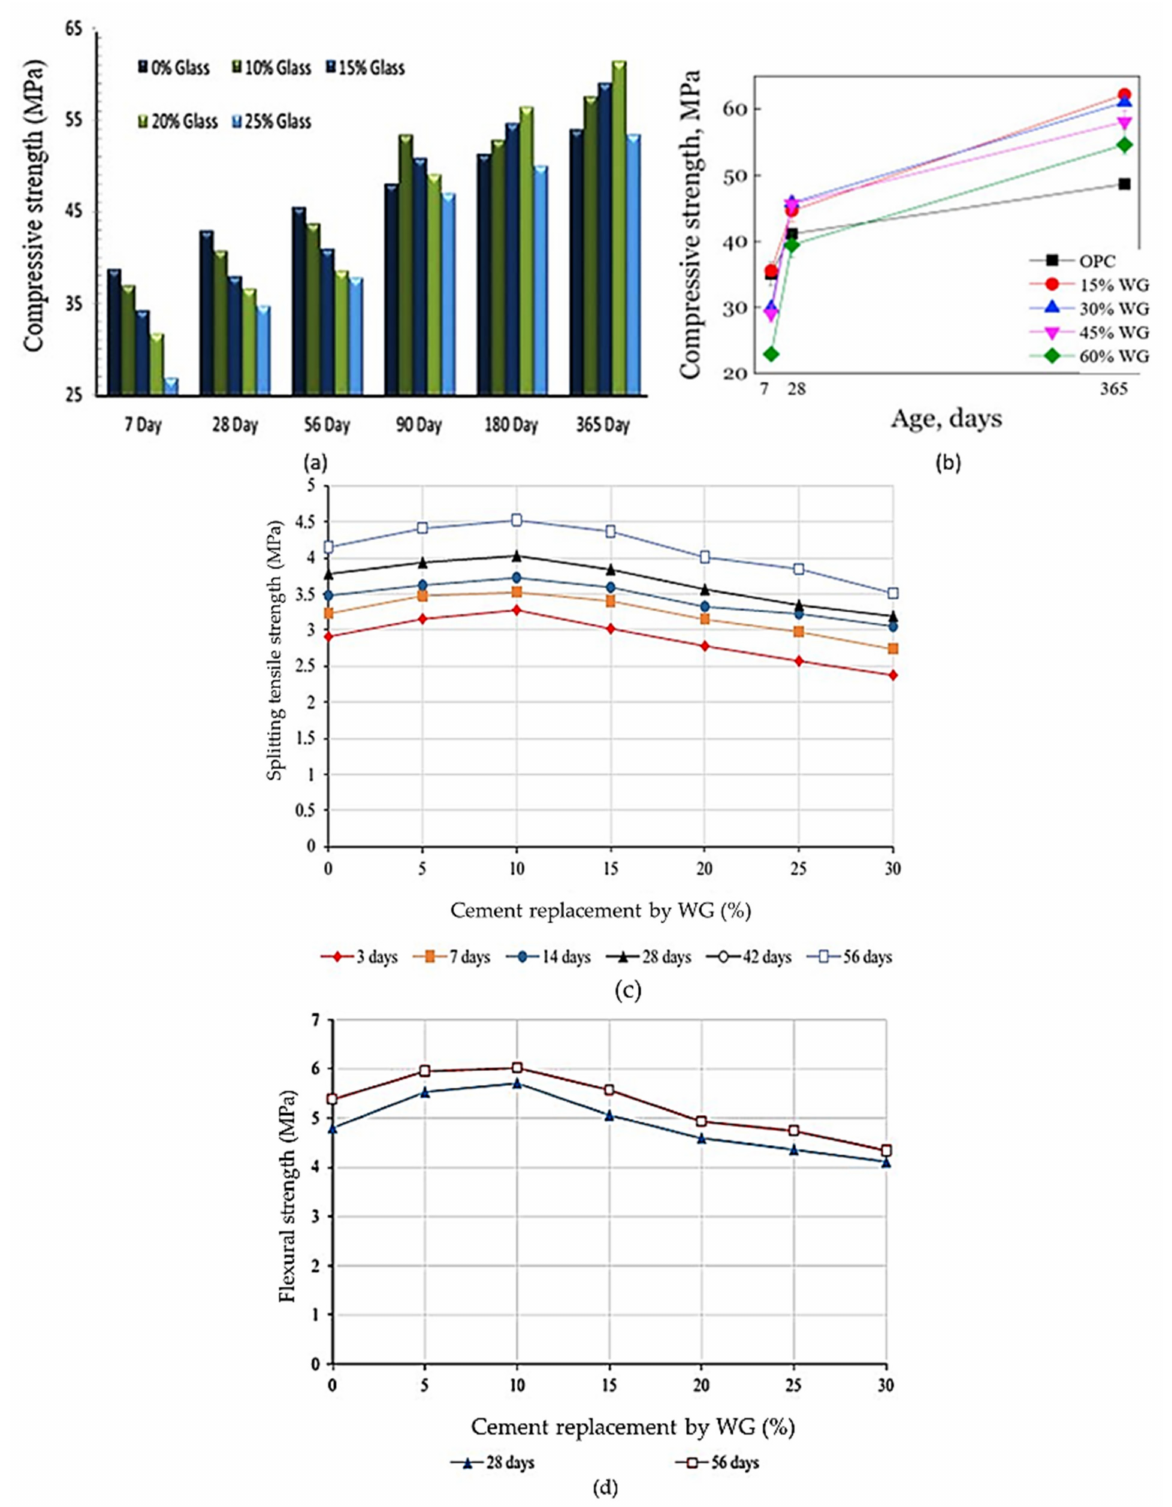
Figure 11. The variation in the strength of concrete with WG as SCM. ( a ) Compressive strength of concrete with WG powder (Particles < 75 µ m) in replacement of cement [36]. ( b ) Compressive strength of WGC with WG powder (particles < 120 µ m) as SCM [57]. ( c ) Splitting tensile strength of concrete with varying content of WG (Particles < 100 µ m for cement replacement) and curing periods [75]. ( d ) Flexural strength of concrete with WG (Particles < 100 µ m for cement replacement)